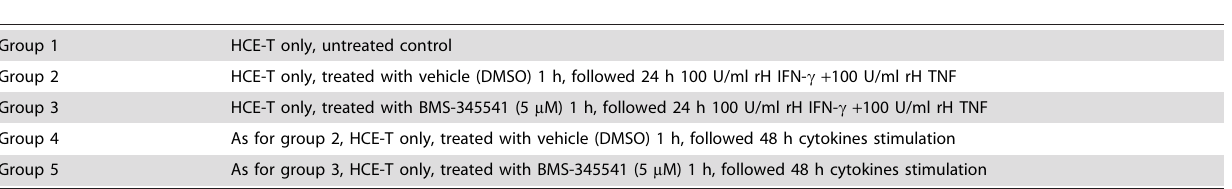
Table 2. Groups for NF- k B